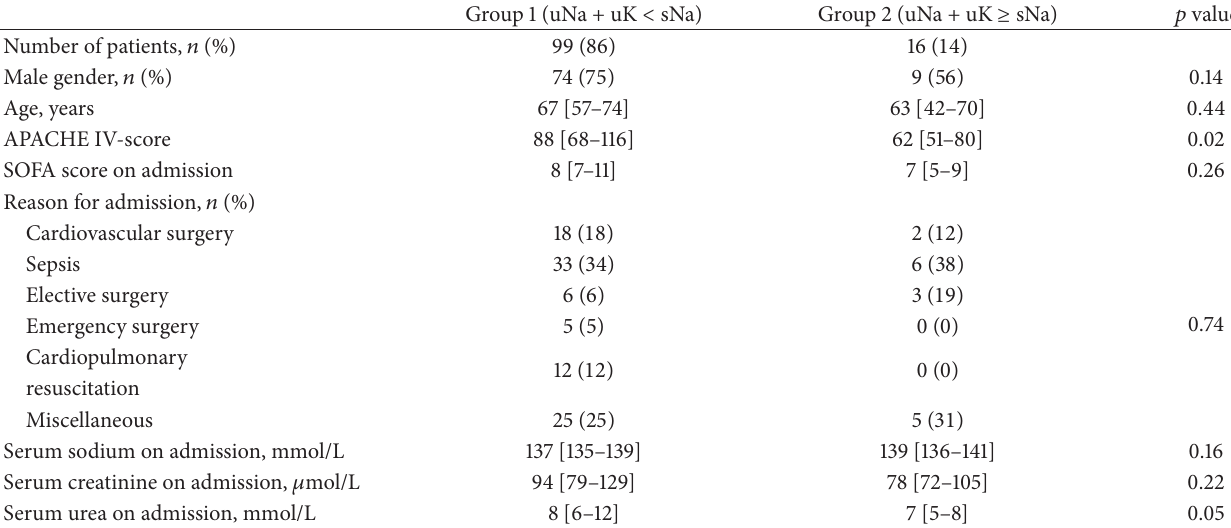
Table 4: Baseline characteristics renal cation excretion study.